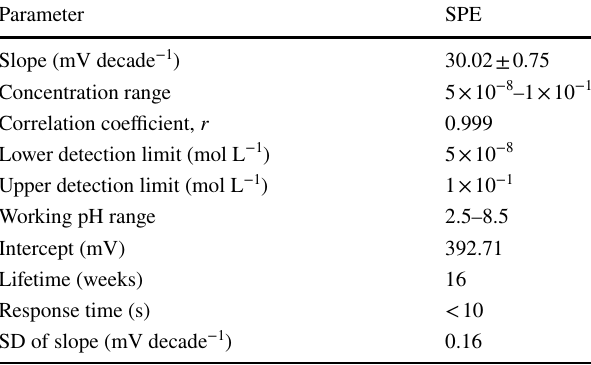
Table 1 Response characteristics of modified MSPE sensor